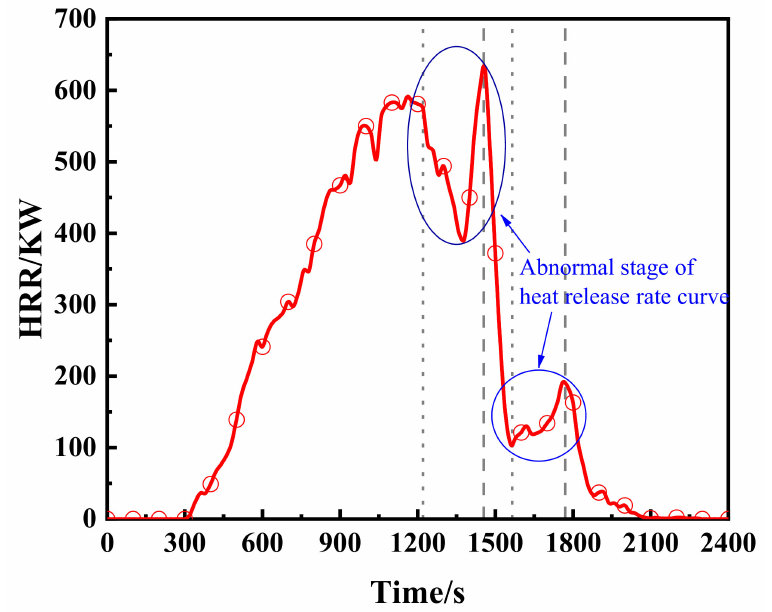
Figure 6. Heat release rate curve.